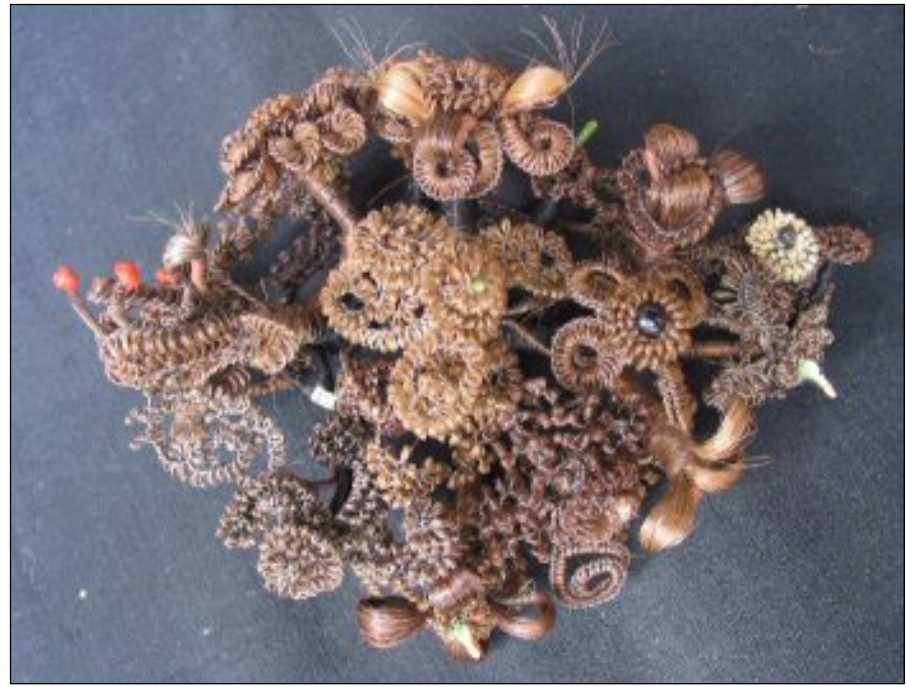
Figure 1. Hair Bouquet, Late-Nineteenth-Century, Omaha,